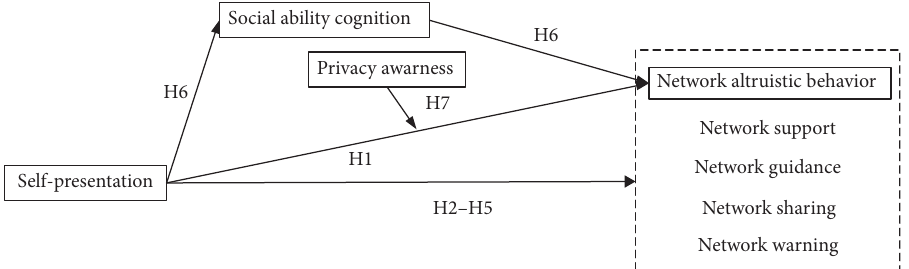
Figure 1: Theoretical framework of adolescents’ self-presentation and social network altruistic